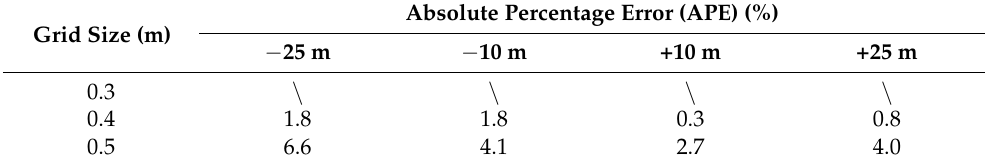
Table 8. Independent verification of grid